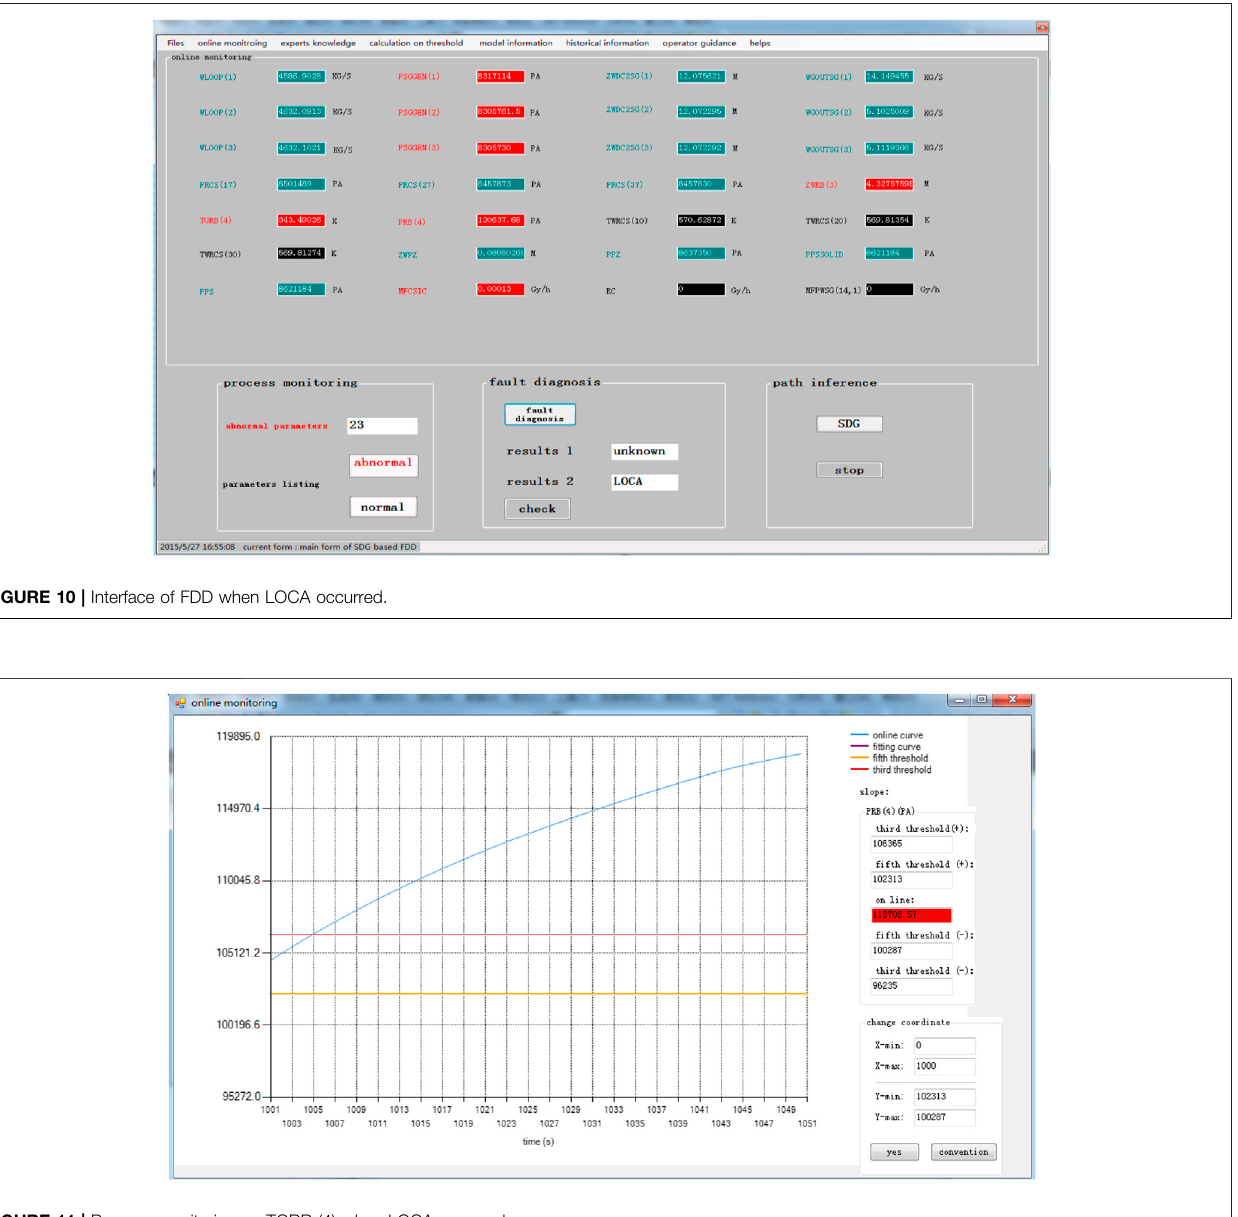
FIGURE 11 | Process monitoring on TGRB (4) when LOCA